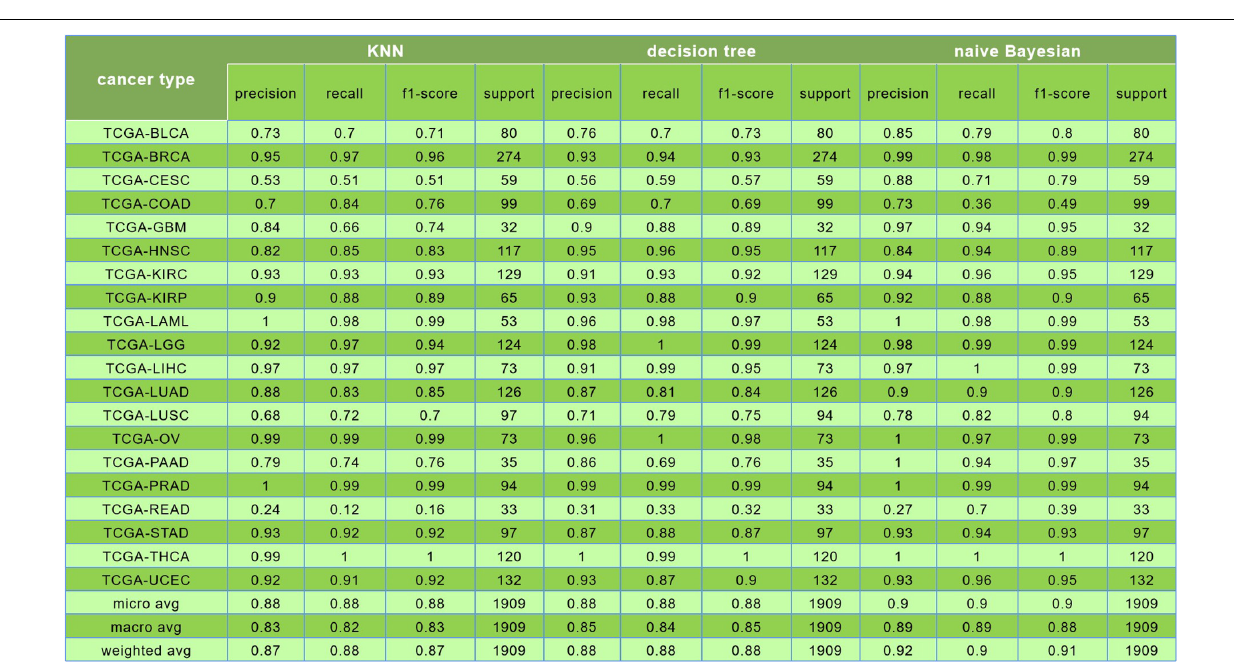
FIGURE 8 | In this figure, the first was the result of k-nearest neighbor ( k = 5) algorithm, and its prediction accuracy was only 88%; the second was the result of decision tree algorithm, and the classification accuracy was only 88%; the third is the result of naive Bayesian algorithm, and the classification accuracy was reaching to